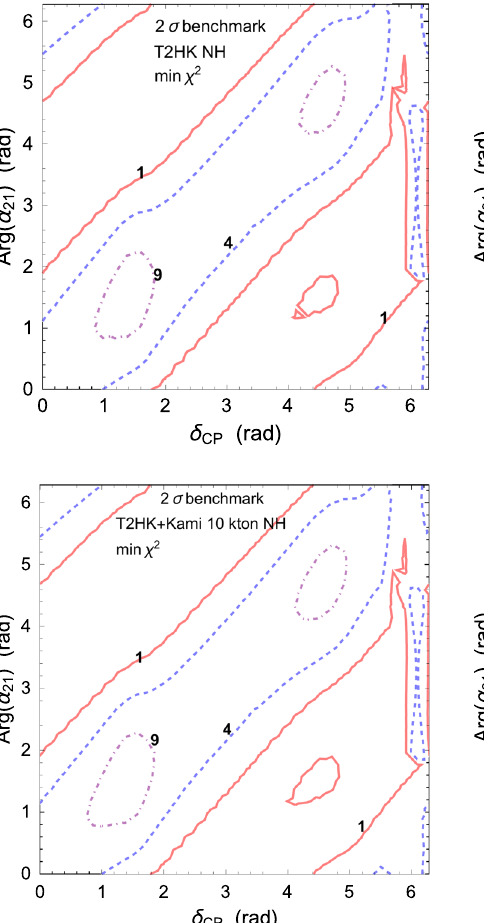
The plot for { min χ 2 ( wrong H ) − min χ 2 ( true H ) } in